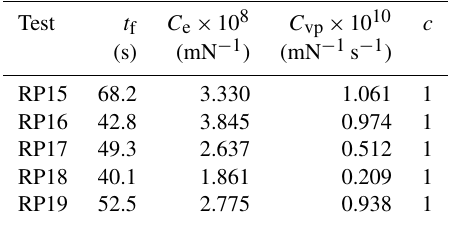
Table 2. Optimization results computed using Schapery’s